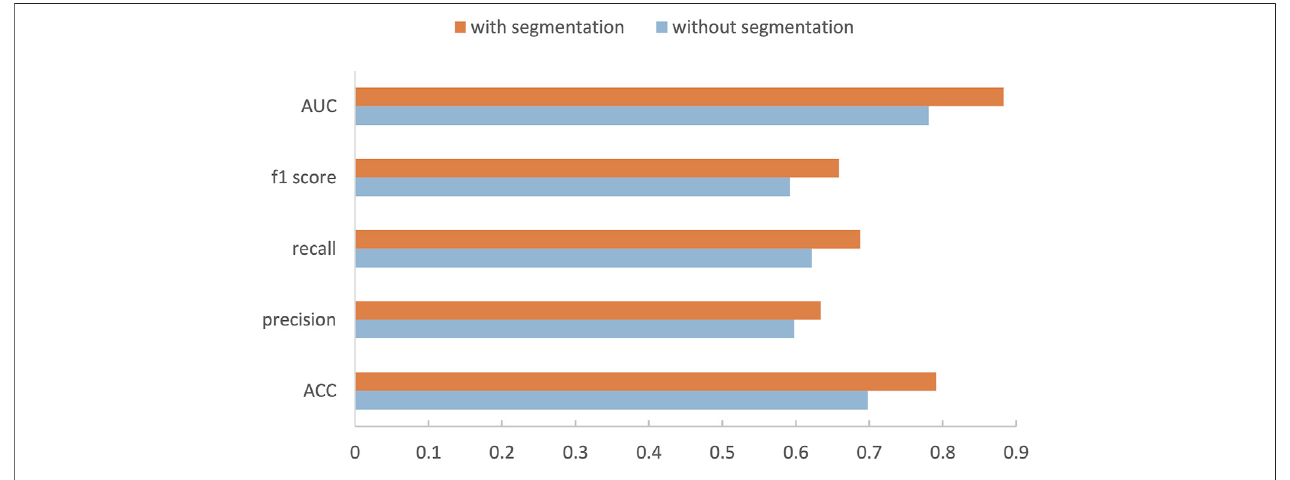
FIGURE 6 | Performance of our method with or without segmentation.